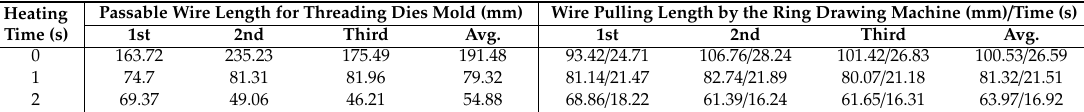
Table 2. Results based on wire pulling speed: k2(3.78 mm / s).